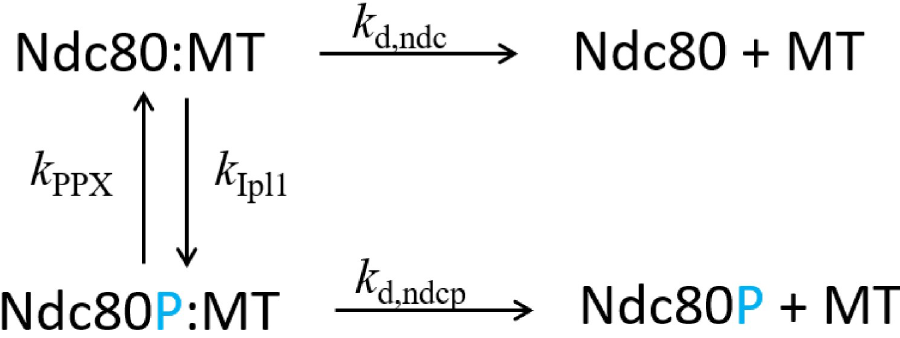
Fig 7. Dissociation scheme of Ndc80-MT